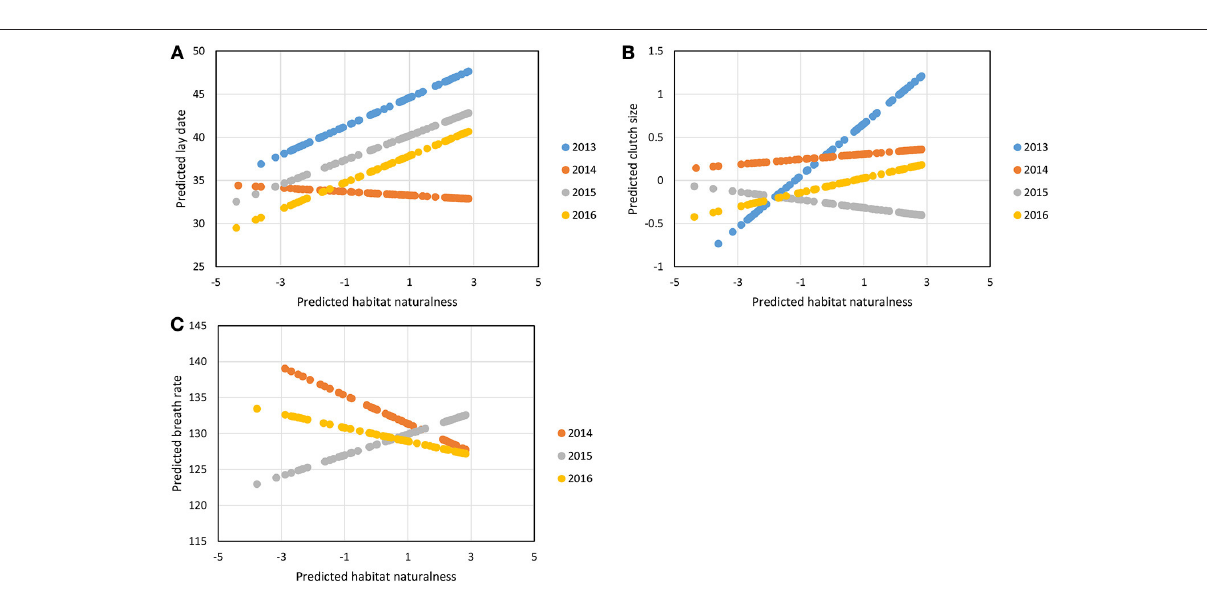
FIGURE 3 | Predicted variation in great tit lay date (A) , clutch size (B) , and breath rate (C) along the naturalness gradient in the city of Montpellier, for each year of data sampling, from the best linear mixed models, presented in Table 4 . For lay date, 1 = 1st March. Breath rate is in number of